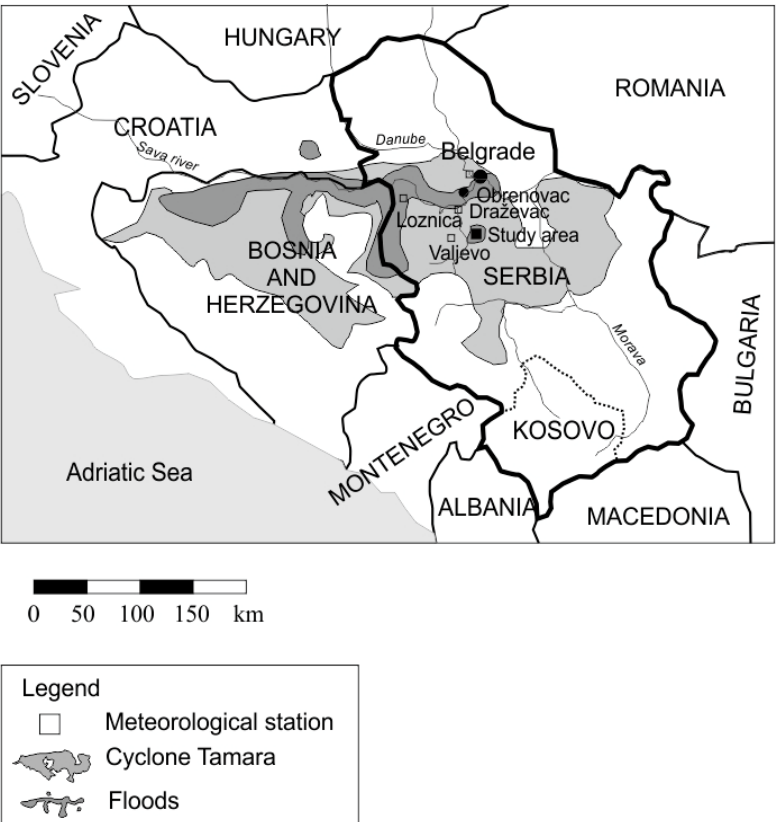
Figure 1. Geographic location.